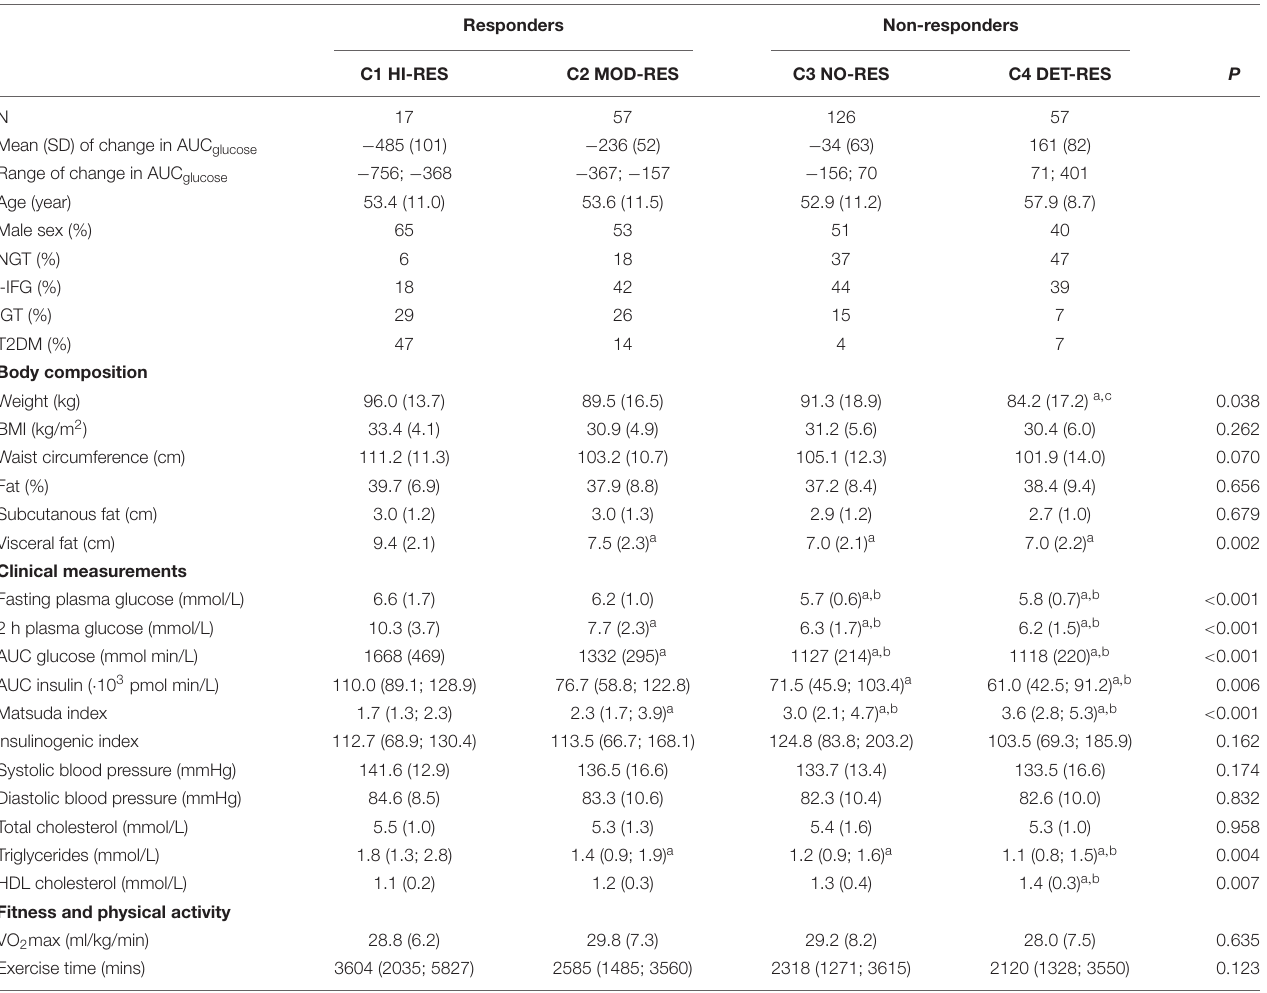
TABLE 4 | Baseline characteristics based on the clusters of change in AUC glucose (imputed